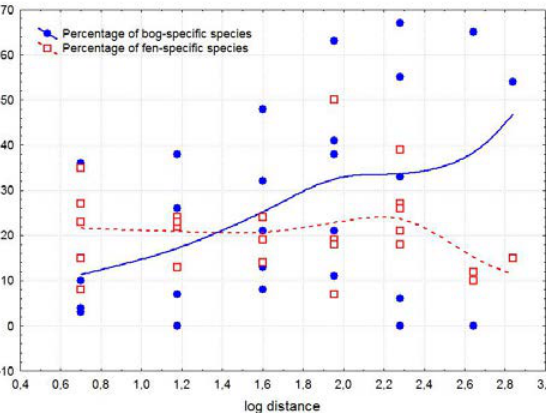
Figure 13. Relationships between percentages of bog-specific and fen-specific species, and log- distance from the cutoff ditch.